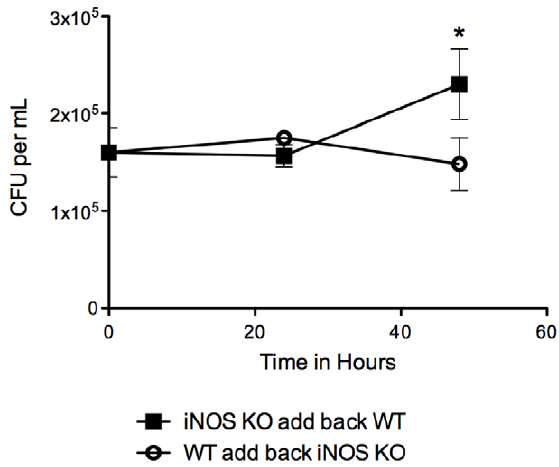
Figure 5. Antimycobacterial activity in macrophage co-cultures requires iNOS expression in the infected cell population. Co- cultures were established with M.tb -infected iNOS 2 / 2 macrophages and uninfected wildtype macrophages ( iNOS 2 / 2 AB WT ) or vice versa ( WT AB iNOS 2 / 2 ). CFU was measured at 0, 24 and 48 h post-addition of naı¨ve macrophages. Results are expressed as mean CFU/ml 6 SD at the indicated times. *, p , 0.01 comparing CFU between groups at 48 h.